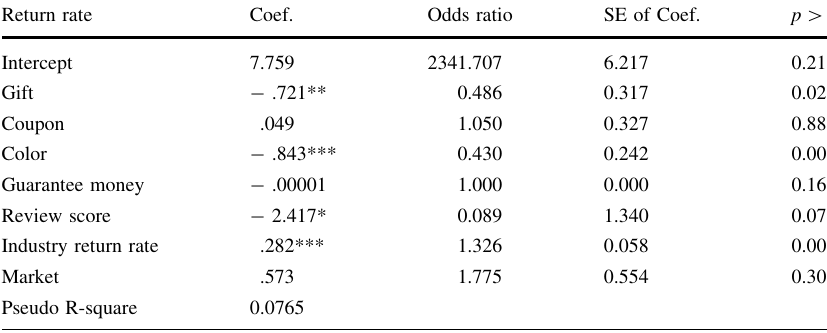
Table 9 Results of regression model for fractional response variables Return rate Coef. Odds ratio SE of Coef.